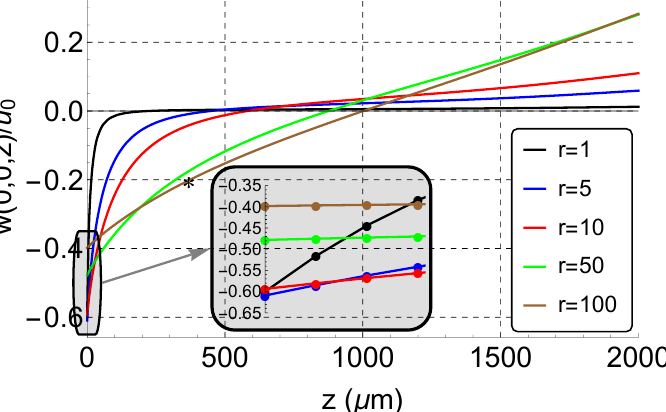
Figure 5. Variation in the normalized surface deformation as a function of surface wave